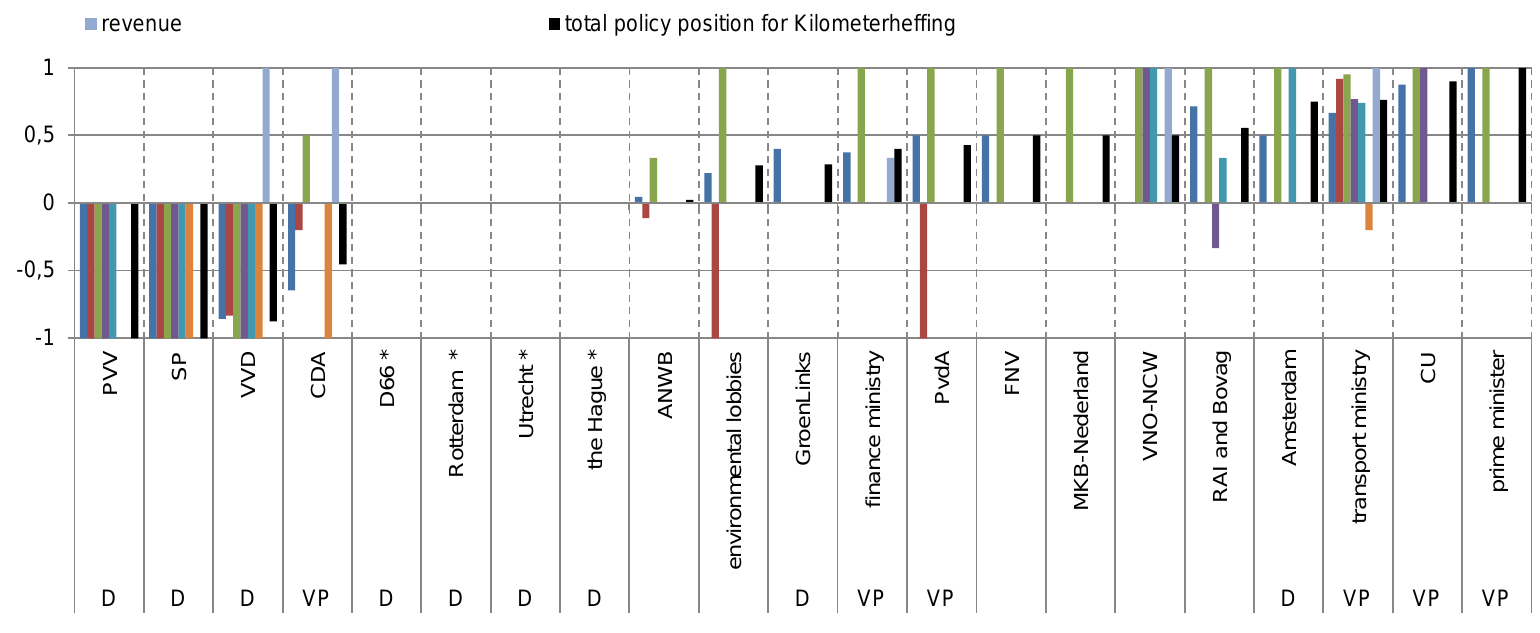
Figure 5. Pro- and anti- Kilometerheffing advocacy coalitions in government period 6 (2007 -